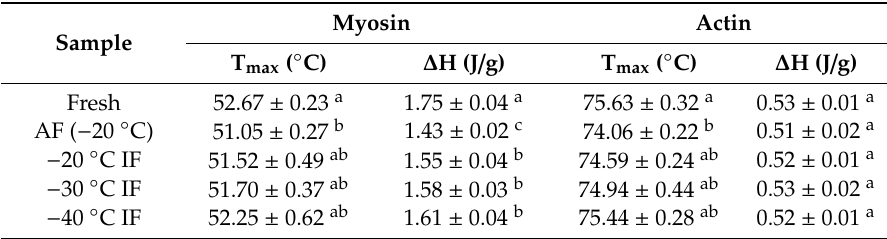
Figure 4. Changes in differential scanning calorimetry (DSC) scanning curve of snakehead muscle under different freezing conditions. Table 4. DSC analysis results for different freezing processes.